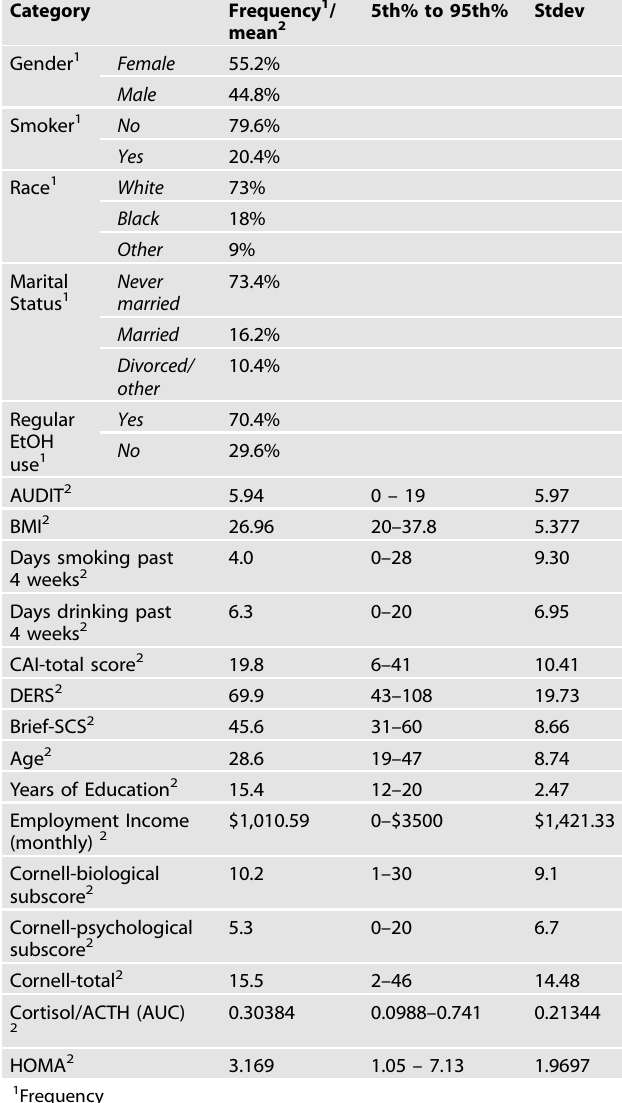
Table 1. Demographics of community